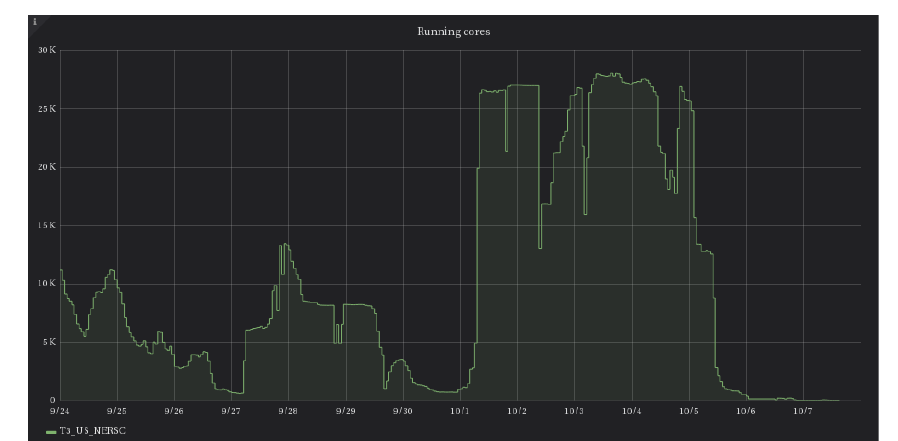
Figure 4. Cores in running CMS jobs at NERSC